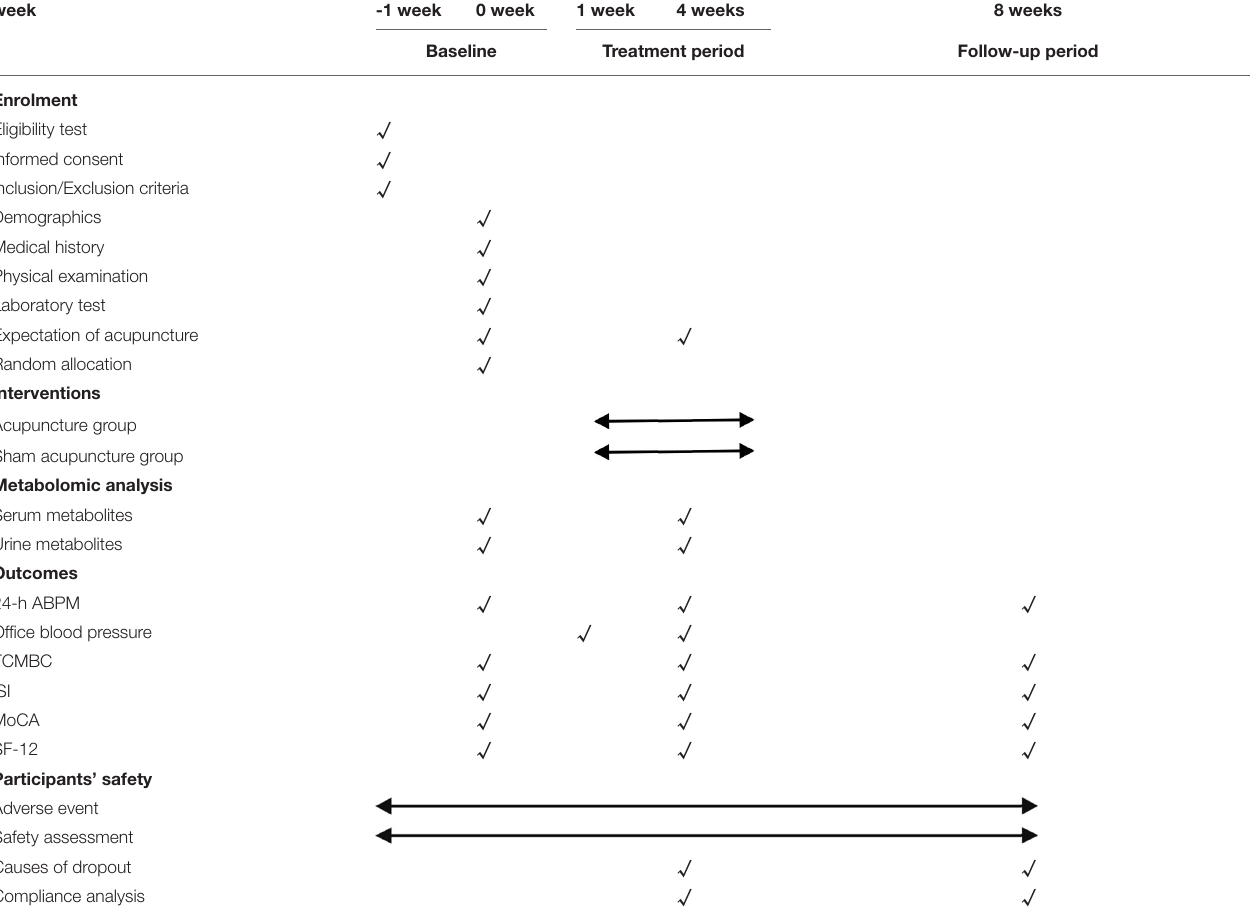
TABLE 1 | Trial process chart. week -1 week 0 week 1 week 4 weeks 8 weeks Baseline Treatment period Follow-up